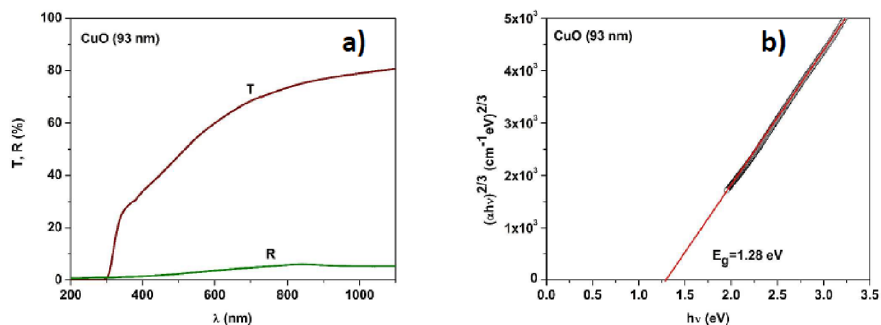
Figure 19. Transmittance and reflectance spectra ( a ) and the plot of ( α h ν ) 2/3 vs. h ν of the copper oxide film (CuO) deposited by the automated SILAR prototype at 10 cycles ( b ).